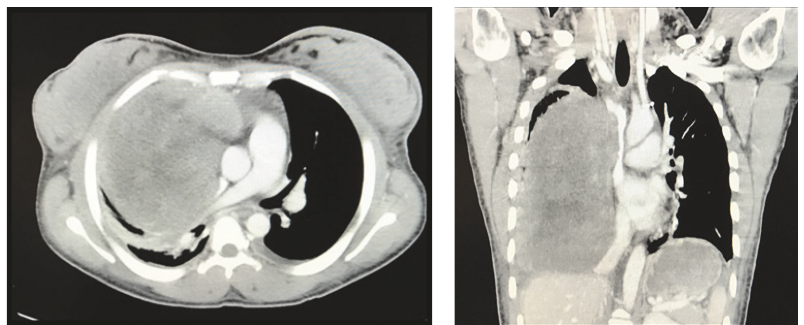
Figure 3: Chest CT showing the superior vena cava obstruction.